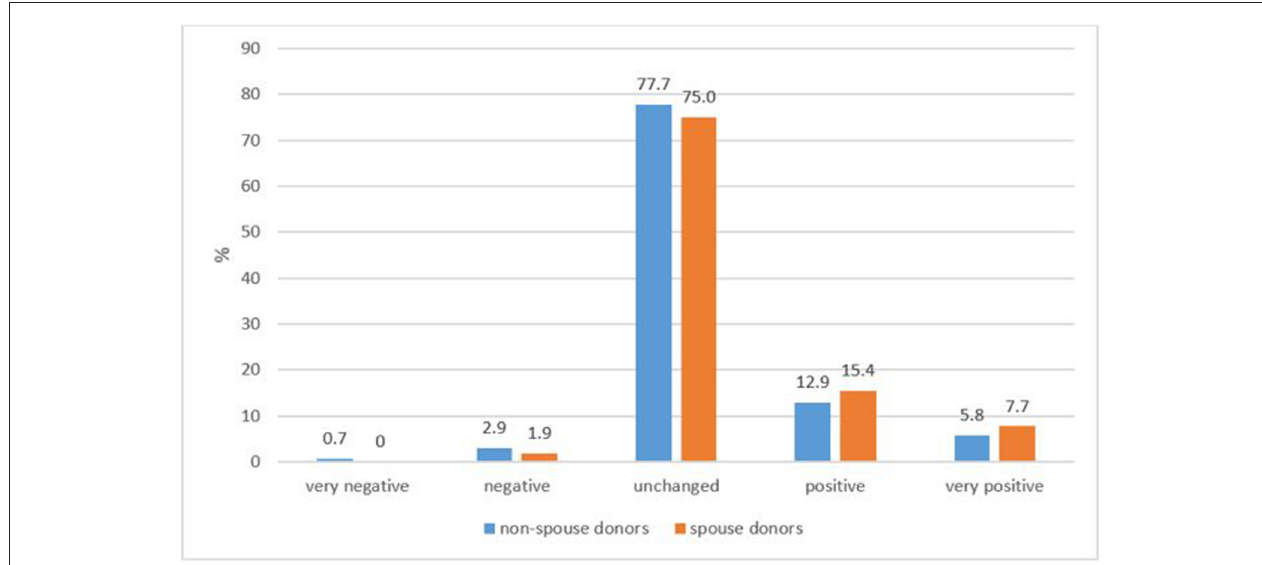
FIGURE 3 | Change in the relationship since transplantation between donor and recipient (donor’s perspective).